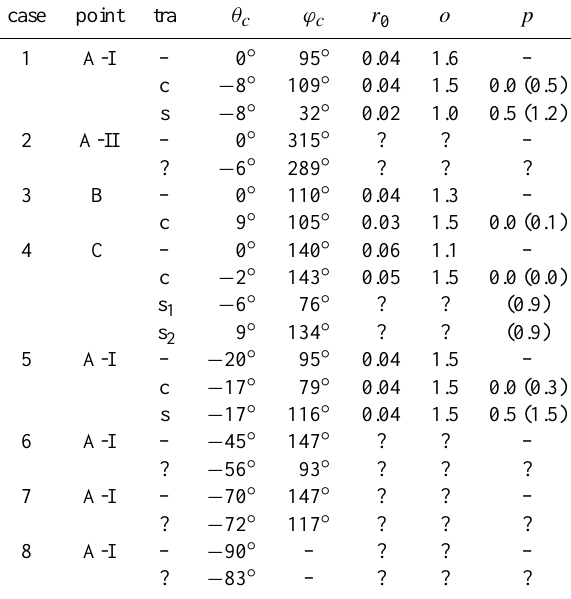
Table 1. True and modeled parameters of magnetic flux ropes. The lines, where the trajectory column (tra) is marked by “–”, give true parameters (“c” and “s” mean central and side crossings, respec- tively). The r 0 is in AU, o is oblateness ( a/b where b = r 0 ). Unde- termined or non-reliable parameters are labeled by ?, the p column shows true values in